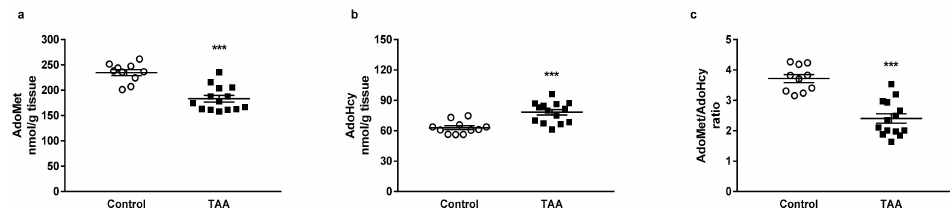
Figure 2. The AdoMet ( a ) and AdoHcy ( b ) tissue levels and ( c ) AdoMet / AdoHcy ratio in the cerebral cortex of control and TAA rats. All data are presented as an overlaying scatterplot of single data points ± SEM, n = 10–14. *** p < 0.001 compared with control.